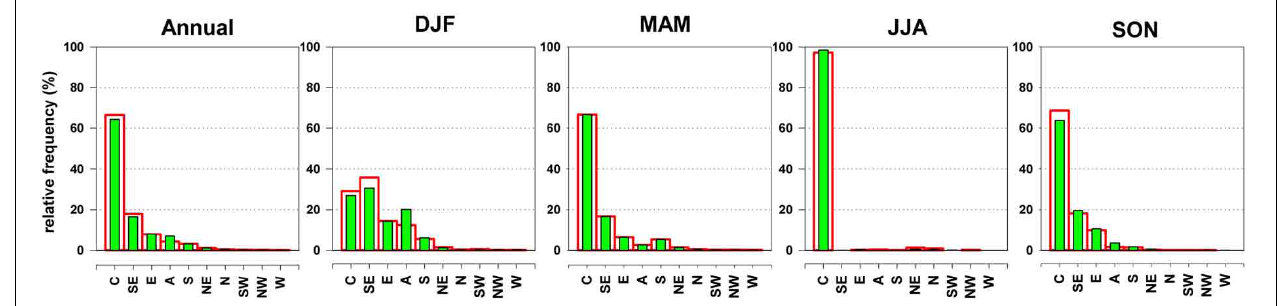
FIGURE 3 | Annual and seasonal counts of the 10 basic Lamb weather types using SLP data from the NCEP/NCAR (red) and the ERA40 (green) data